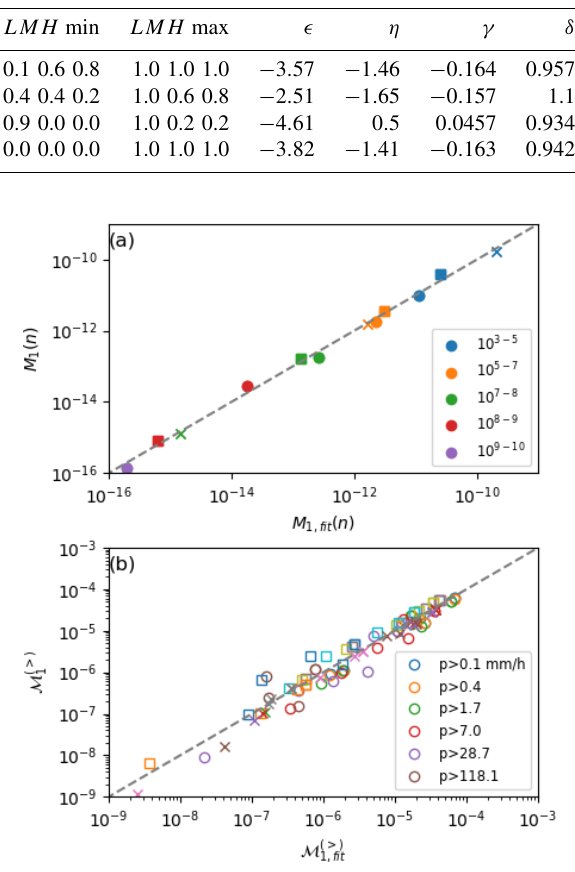
Figure 6. The single-moment reconstructions of the rainfall rate distributions. (a) The simulated rainfall amounts (vertical axis), compared to the values predicted by the single-moment closure, using the aerosol-concentration-dependent power-law relationships between the zeroth and first moments of the CDNC-conditioned dis- tributions. The circles, squares and crosses correspond to the high-, intermediate- and low-aerosol-concentration experiments, respec- tively. The colours indicate the CDNCs. (b) The simulated (vertical axis) upper partial first moments of the rainfall rate distributions, compared to the values predicted by the single-moment closure. The colours indicate the precipitation-rate thresholds above which rain- fall is